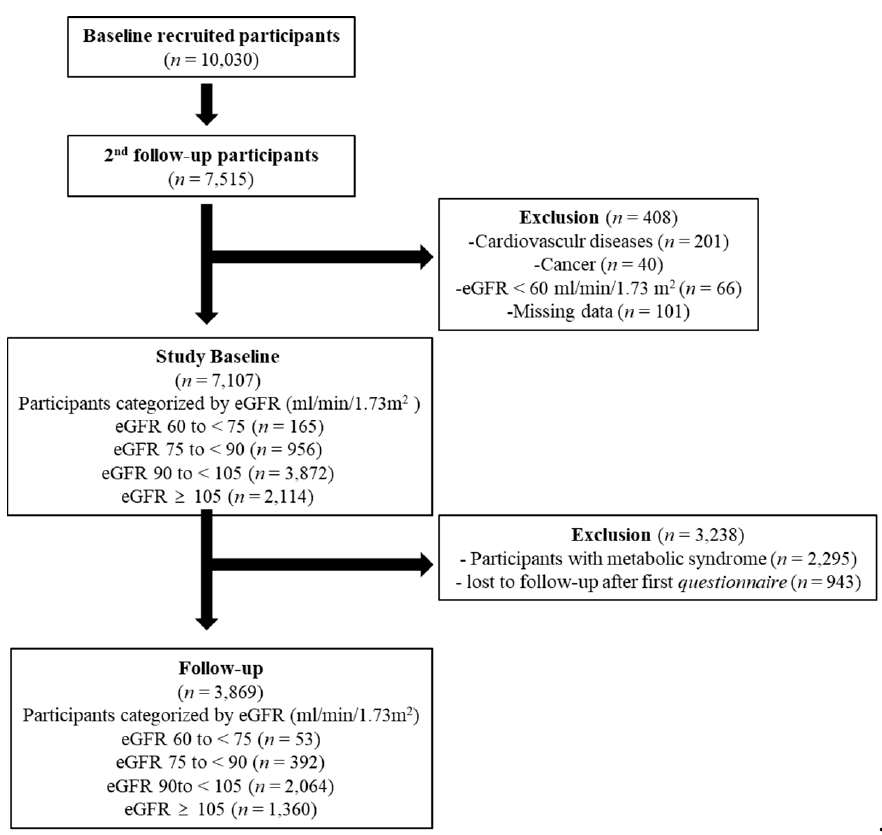
Figure 1. Flowchart of the study participants. eGFR: estimated glomerular filtration rate.